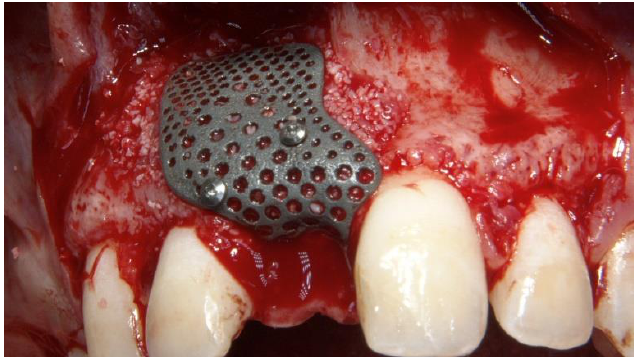
Figure 5. Intraoral view of the customized titanium mesh fixed using two titanium pins.